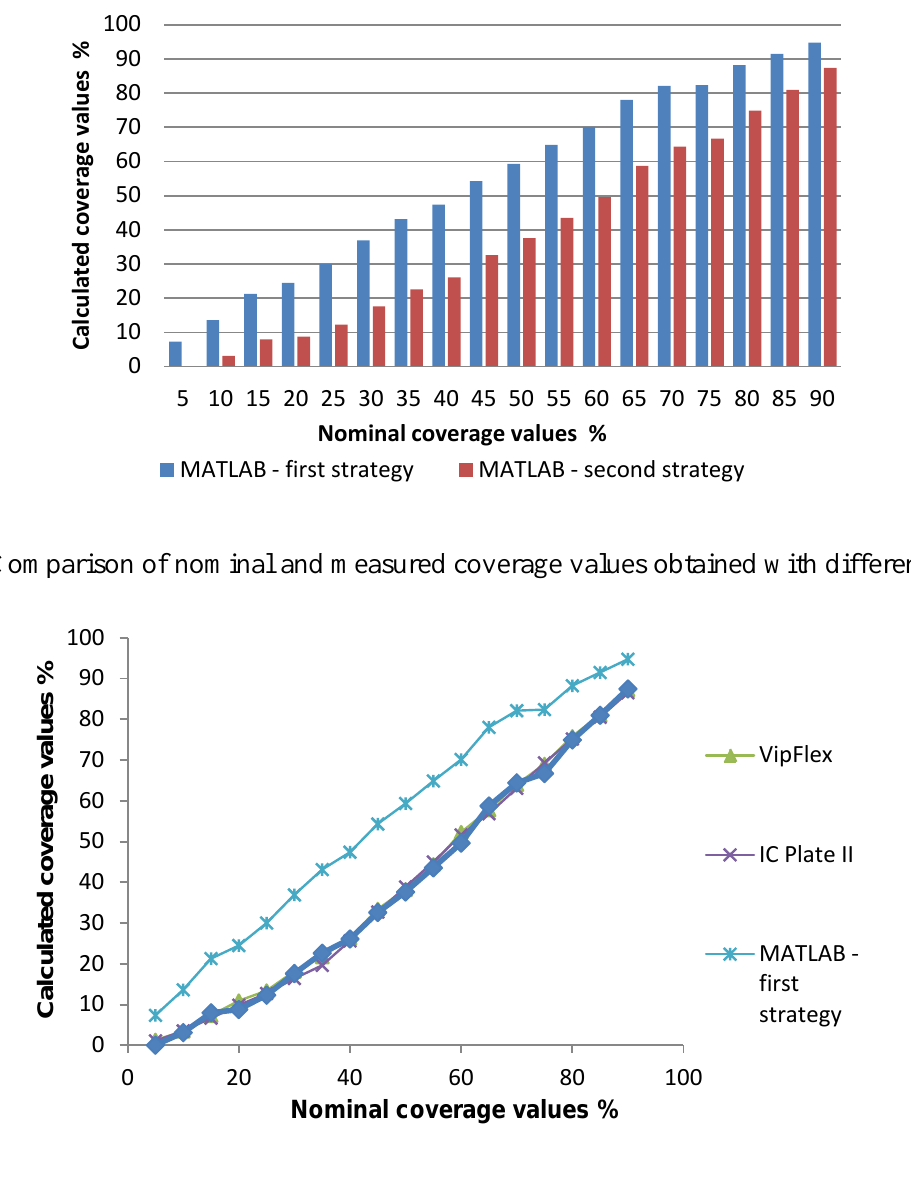
Figure 16. Results of total coverage obtained with the first and second strategy.